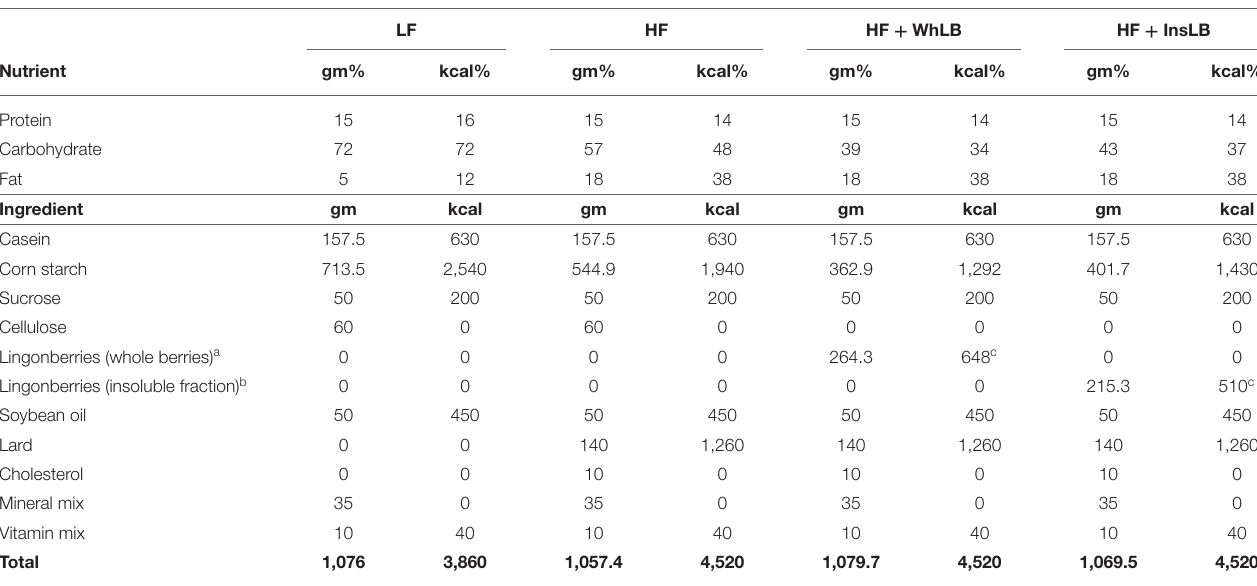
TABLE 1 | Composition of the experimental